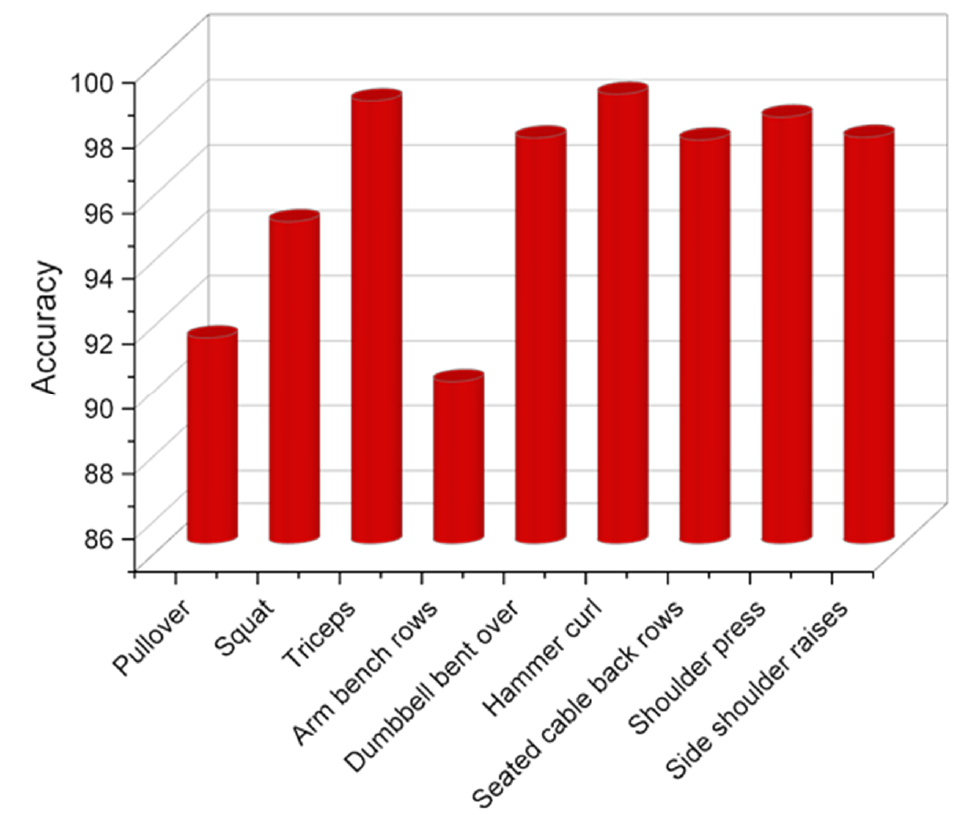
Figure 13. Accuracy of repetition counting algorithm for each sport type.